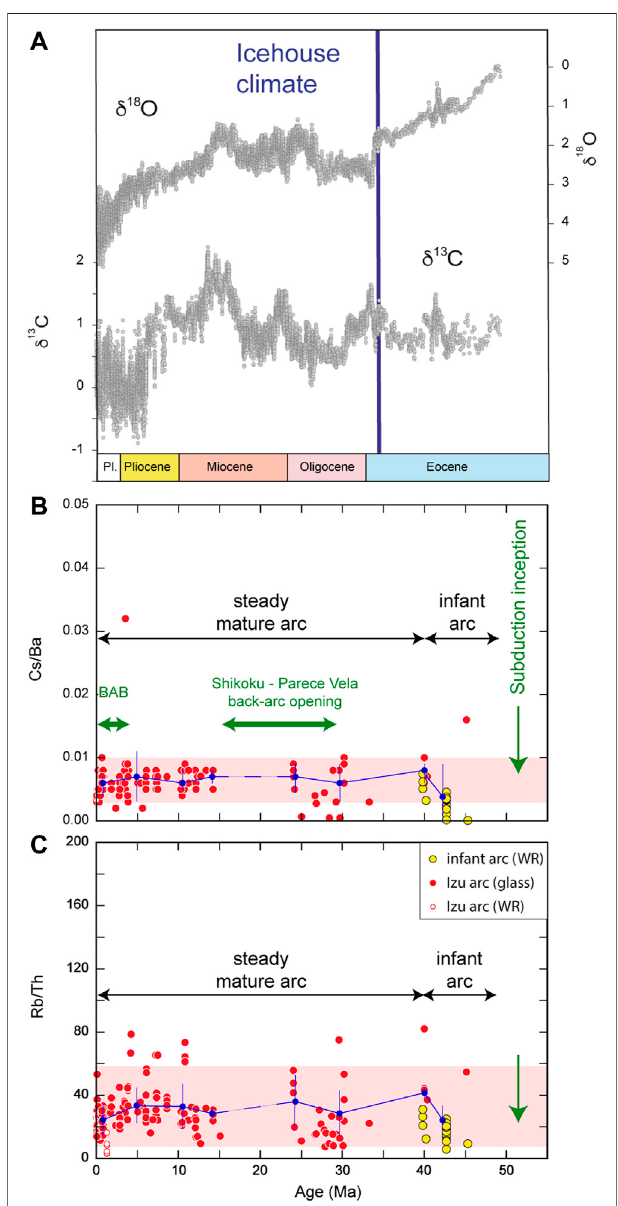
FIGURE 9 | Comparison between the markers of climate variations and slab dehydration for the past 45 Ma. (A) Markers of past climate variations δ 18 O and δ 13 C (Zachos et al., 2001). The general decrease in δ 18 O since the middle Eocene reveals a decrease in the Earth ’ s surface temperatures for the past 45 Ma (Zachos et al., 2001). (B) Cs/Ba and (C) Rb/Th ratios used to track the aqueous (volatile-rich) slab fl uids released underneath the Izu arc for the past 45 Ma. The blue line represents an averaged composition of the markers of slab dehydration with 1 σ error bar. There is a slight increase in the markers of slab dehydration at ~ 40Ma (i.e., from the infant to the mature arc); while the long-term averages in the slab- fl uid proxies have remained relatively constant in the mature Izu arc from 40 Ma.